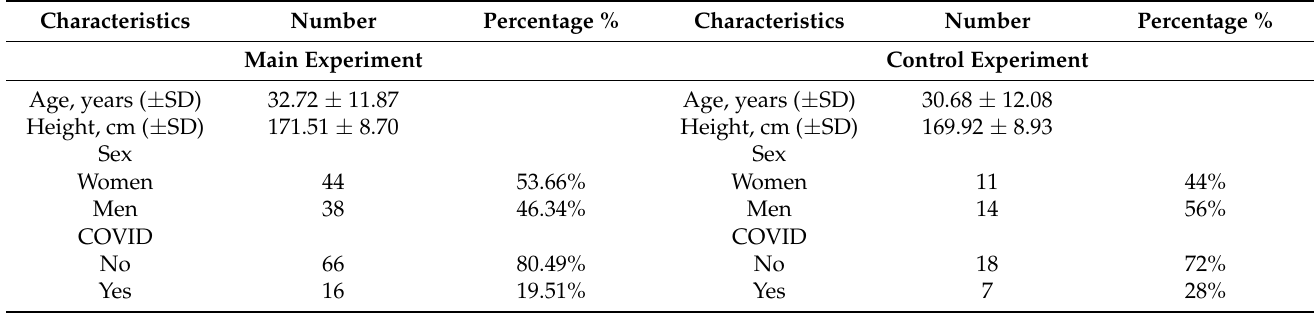
Table 1. Descriptive of the main and control experimental group.